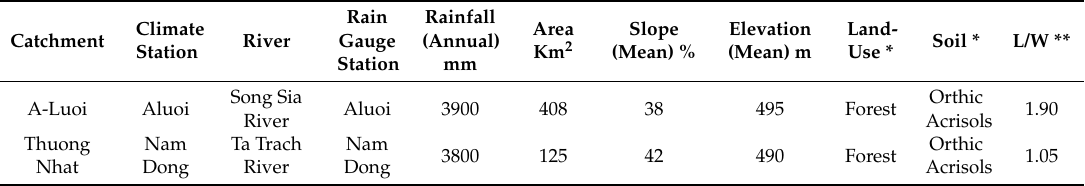
Table 1. Properties of the donor and target